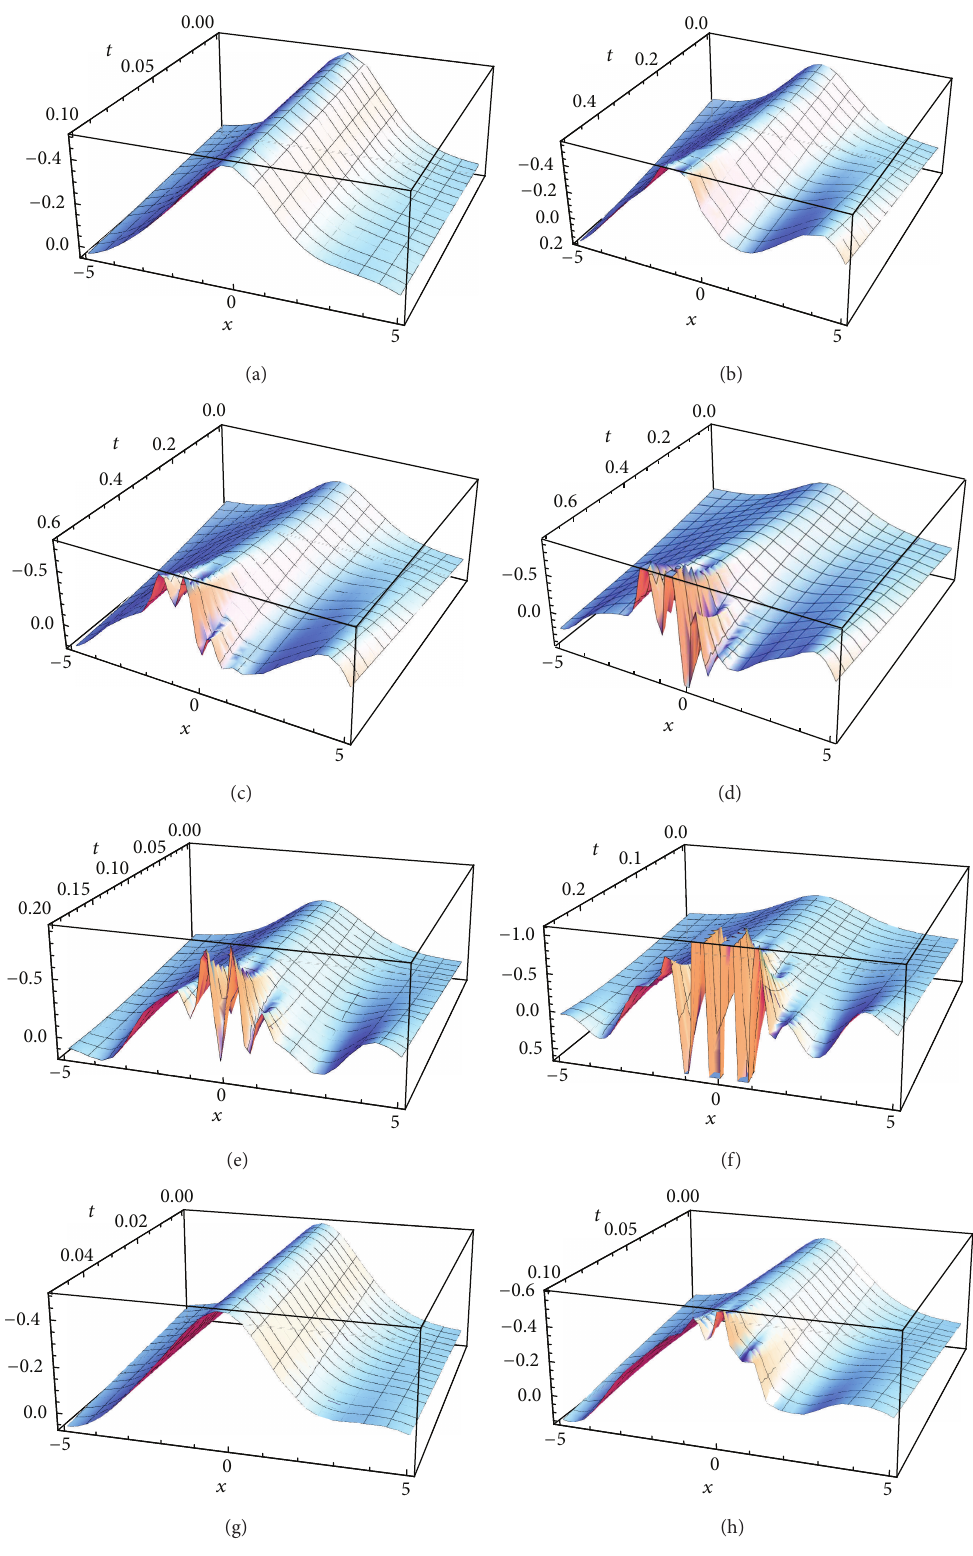
Figure 5: The HAM solution at 9th-order approximation with different convergence values of ℎ . (a, b, c, and d) for ℎ = −0.3 , (e and f) for ℎ = −1.0 , and (g and h) for ℎ = −1.7